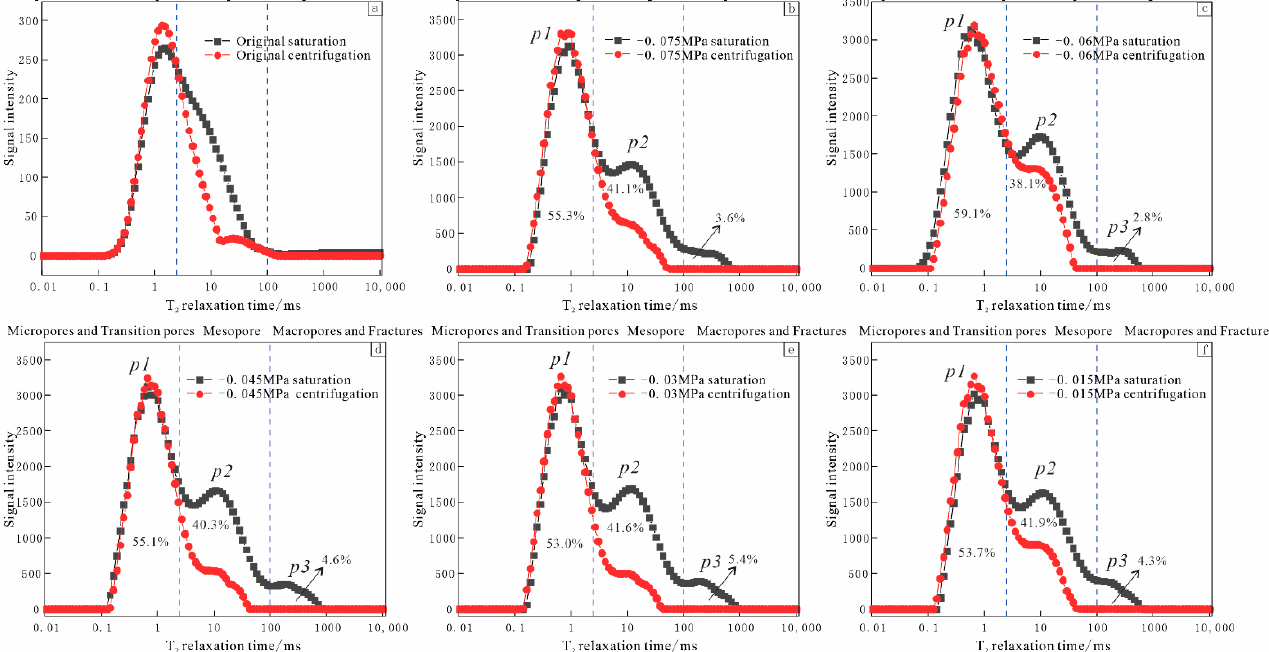
Figure 7. ( a – f ) T 2 relaxation time spectra of low-rank coal samples.